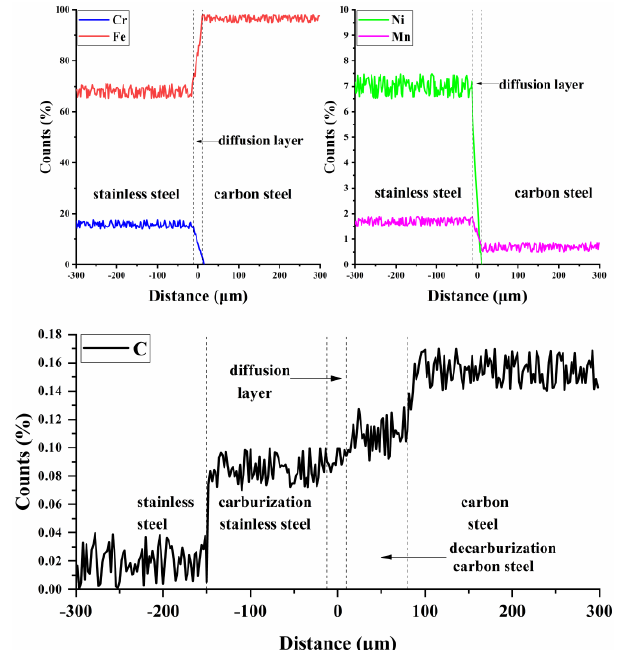
Figure 3. The EPMA line of stainless steel clad plate.